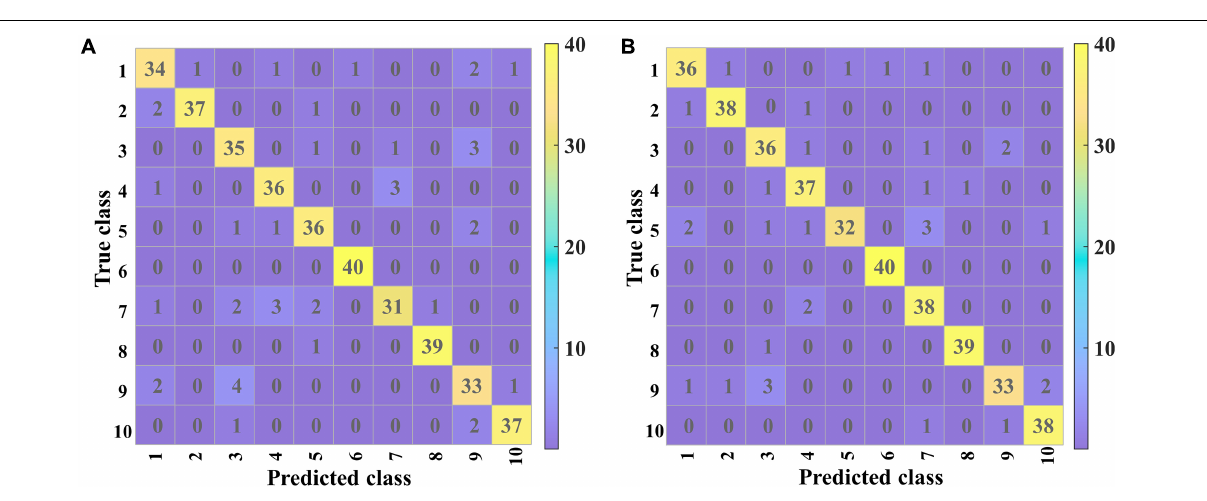
FIGURE 8 | The confusion matrix for the (A) validation and (B) prediction based on